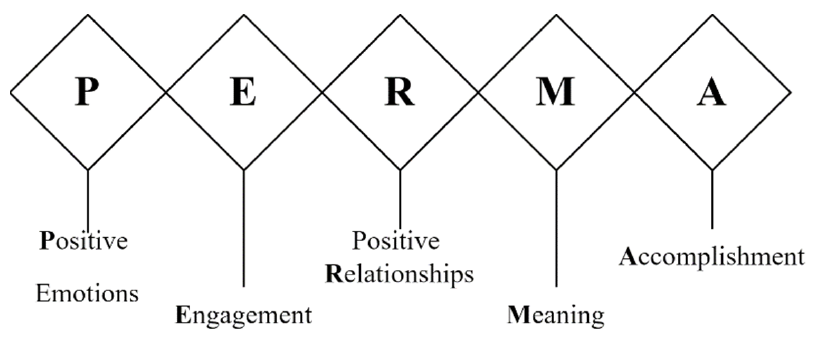
Figure 1. PERMA model [35].